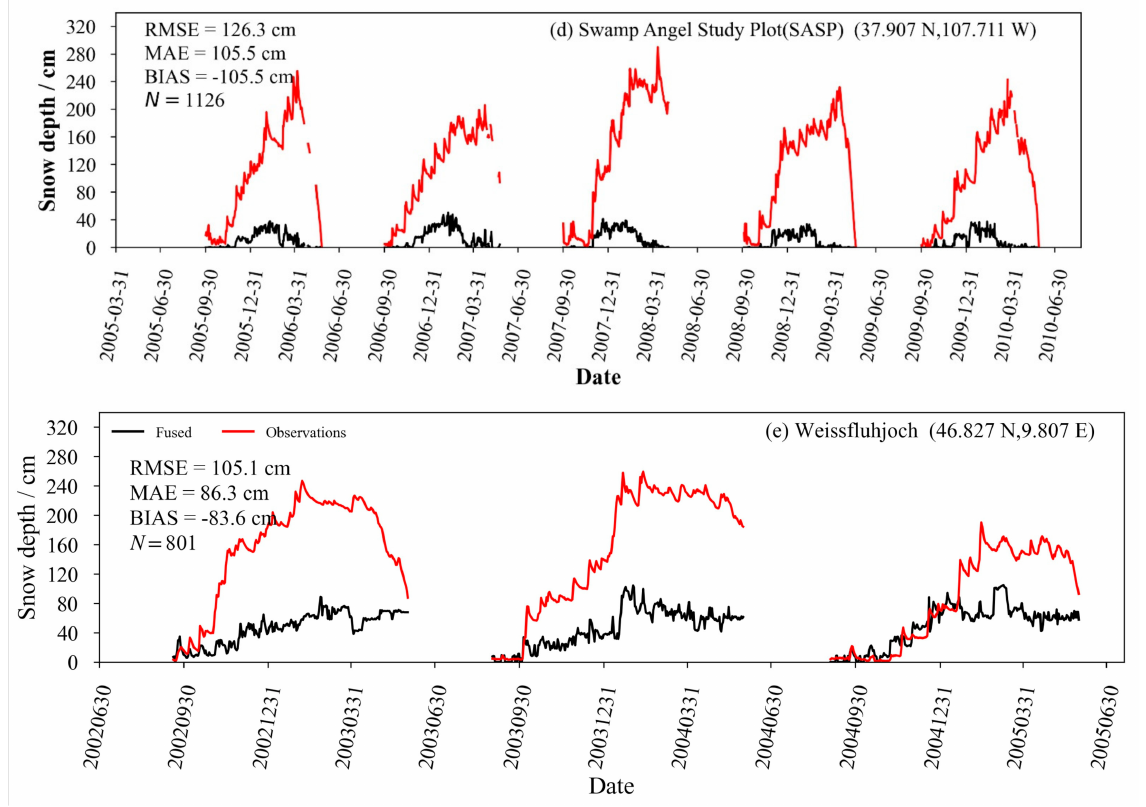
Figure 7. Time series of fused snow depth (black lines) and in situ observations (red lines) at five